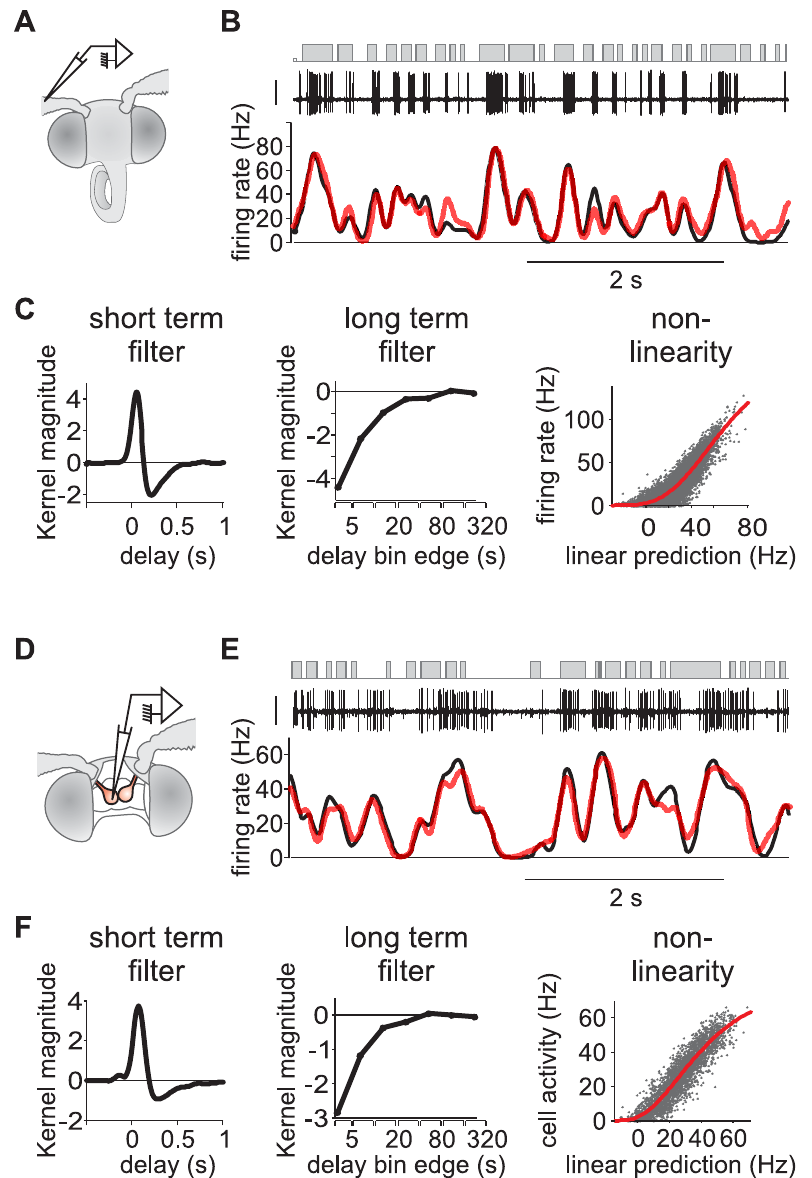
Fig 1. L-N model captures the responses of both ORNs and PNs to white-noise stimuli. (A) Moth preparation for ORN recording.A tungsten electrode is inserted at the basis of a sensillum. (B) Response of an ORN to white-noise odor stimuli (correlationtime 50 ms). Top: stimulus sequence(puffs in grey). Middle: action potentialrecordings(vertical bar 1 mV). Bottom: firing rate dynamic calculatedwith a Gaussiankernel (black) and predictedwith an L-N model (red). For this ORN, the coefficient of determinationbetweenmodel and recordedfiring rates is R 2 = 0.81. (C) L-N model fitted to the responseof the same neuronas in (B) to 15 min of white-noise stimuli. Left to right: short term linear filter, long term linear filter calculatedon a log time scale, static nonlinearity (grey dots: measuredvs predictedvalues, red line: fitted Hill function). (D) Moth preparation for PN recording.A glass electrodeis insertedin the cumulus of an antennal lobe. (E-F) Same as (B-C) but on a PN. White-noise correlationtime is 50 ms and R 2 = 0.84. total linear filter. Predictions of firing rates using linear filters were frequently negative indicat- ing discrepancies between the measured neuronal activities and their linear prediction. This was expected since neurons are known to be nonlinear integrators of their inputs. Second, a